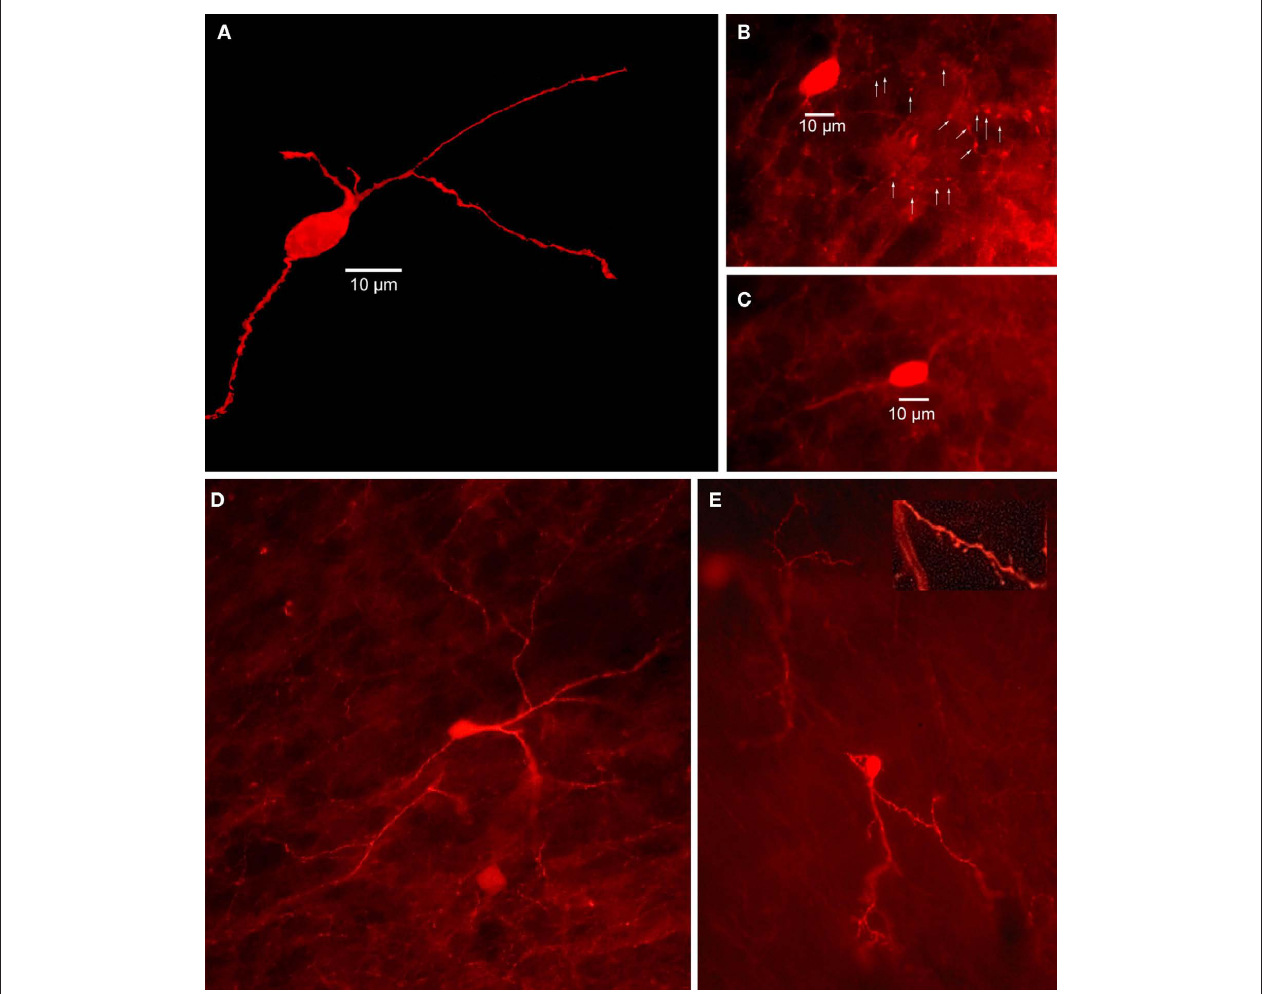
axonal varicosities. (C) Another immunostained aspiny Type I CR + interneuron. (D) Immunostained brightly fluorescent aspiny Type II CR + interneuron just above a less brightly fluorescent Type I CR + interneuron. Note smaller soma of Type II neuron and more high branched dendritic arborization. (E) Least common type of CR + interneuron is the Type III , intensely fluorescent and